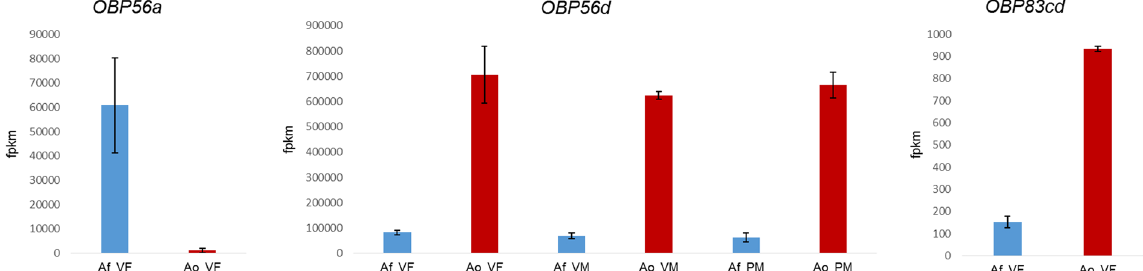
Figure 1. Differentially expressed OBP genes according to RNA-seq data analysis. Af = A . fraterculus (profiles in blue); Ao = A . obliqua (profiles in red); VF = virgin female; VM = virgin male; PM = post-mating male. RNA- seq expression was measured by fragments per kilobase of transcript per million mapped reads (fpkm).